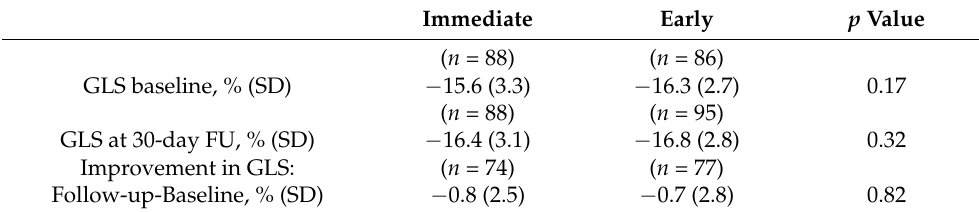
Figure 2. Ejection fraction improvement over time. The ejection fraction of both the im- mediate invasive strategy and early invasive strategy groups at baseline and at 30-day follow-up.